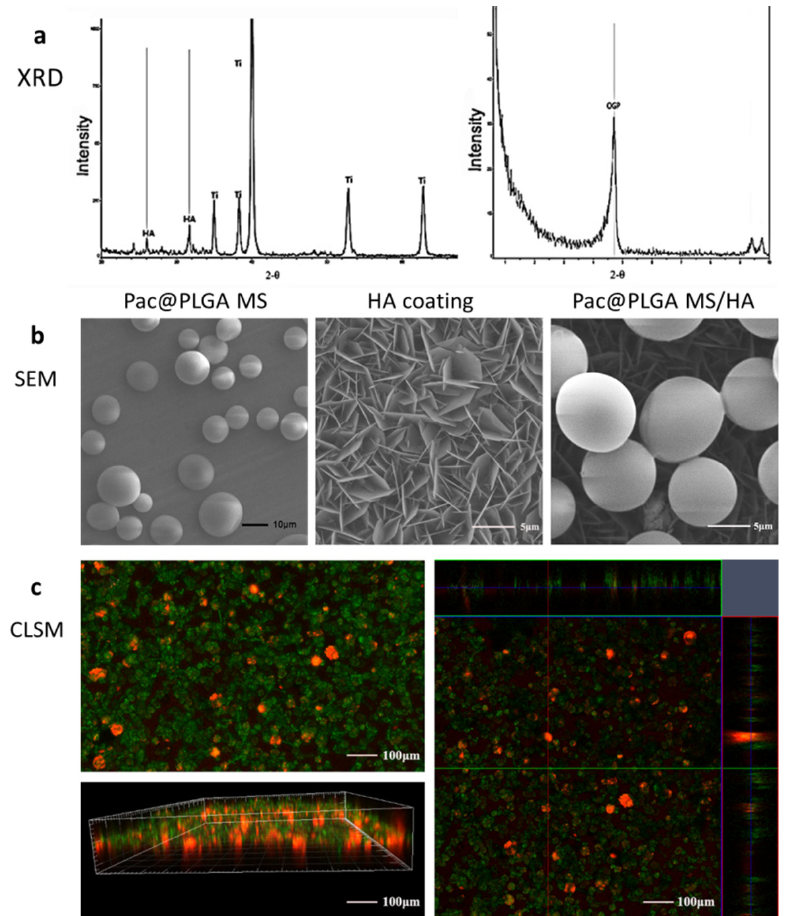
Figure 1. The morphology of PLGA microspheres and HA coating were observed through SEM and CLSM. ( a ) Phase composition of Pac@PLGA MS/HA coating. ( b ) SEM images for the morphology